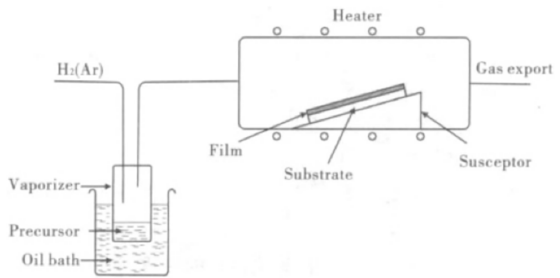
Figure 13. Schematic diagram of the MOCVD principle [70].